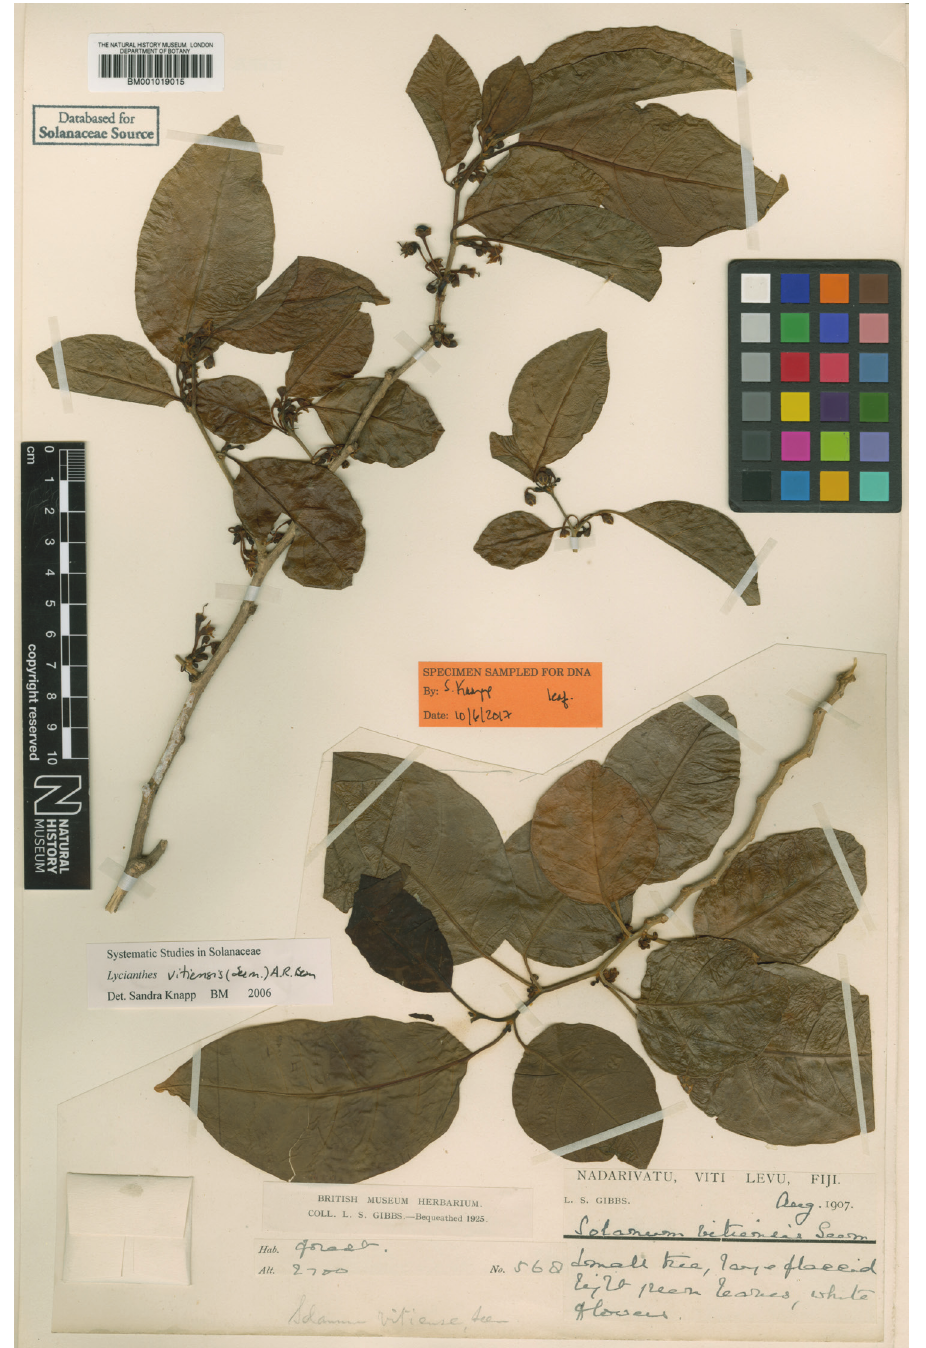
Figure 52. Lycianthes vitiensis herbarium specimen. Fiji. Viti Levu: Gibbs 568 (BM001019015). Courtesy of the Trustees of the Natural History Museum, London, reproduced with